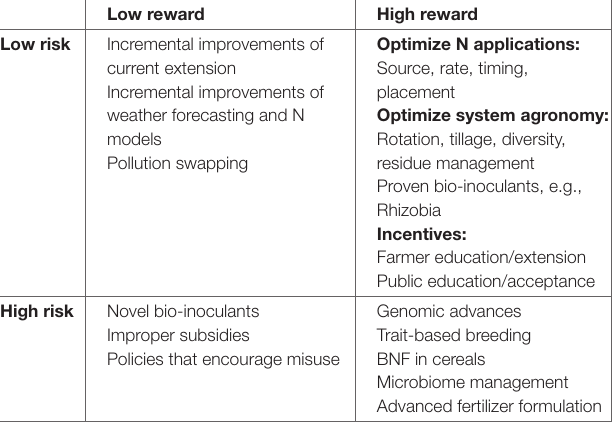
TABLE 1 | A risk-reward matrix organizes possible solutions to the nitrogen problem in four groups based on high or low risk and high or low reward. Low reward High